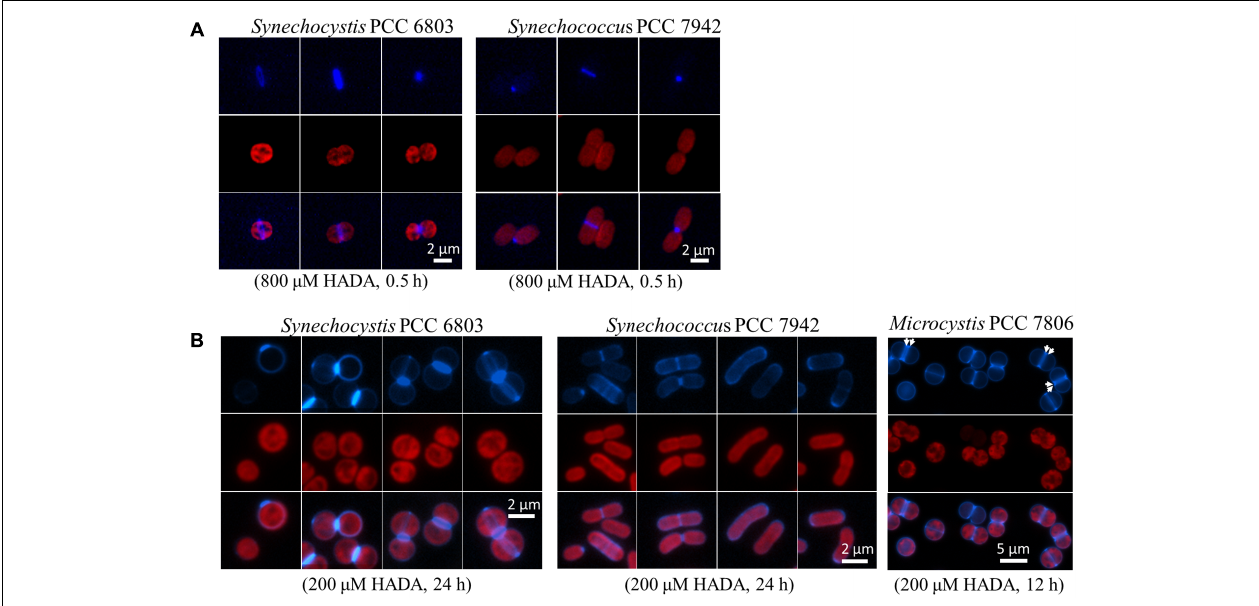
FIGURE 1 | HADA labeling in three unicellular cyanobacteria: Synechocystis PCC 6803, Synechococcus elongatus PCC 7942, and Microcystis PCC 7806. (A) Pulse labeling of Synechocystis and Synechococcus elongatus with a high concentration of HADA (800 µ M) for 30 min, followed by removal of HADA by washing and observation by fluorescence microscopy. (B) Continuous labeling with a low concentration of HADA in Synechocystis , Synechococcus elongatus , and Microcystis . For Synechocystis and Synechococcus elongatus , three or four sets of photos are shown, and each demonstrates a representative HADA labeling pattern. HADA signal is in blue, and photosynthetic pigment in red, and the overlay for the images of same cells acquired through the two channels. Arrows indicates the pre-septal division mode in Microcystis .